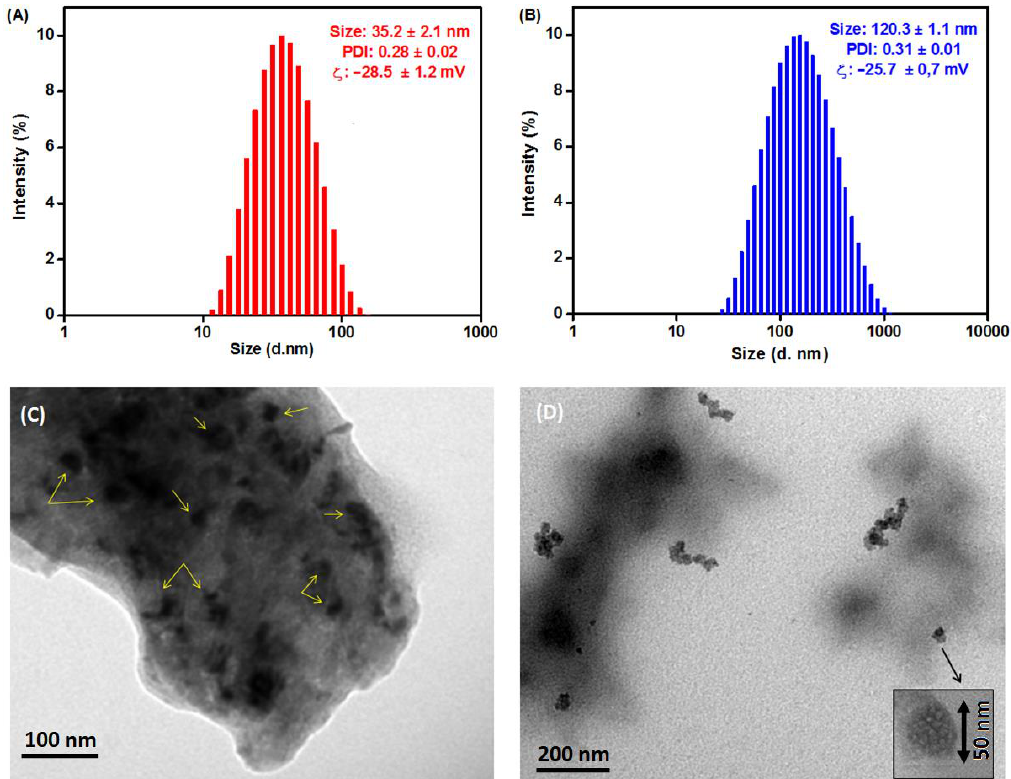
Figure 3. DLS profiles in water of ( A ) β-CD@Cur 4 and ( B ) (β-CD) 2 @Cur 5 . TEM images of ( C ) β-CD@Cur 4 and ( D ) (β-CD) 2 @Cur 5 .